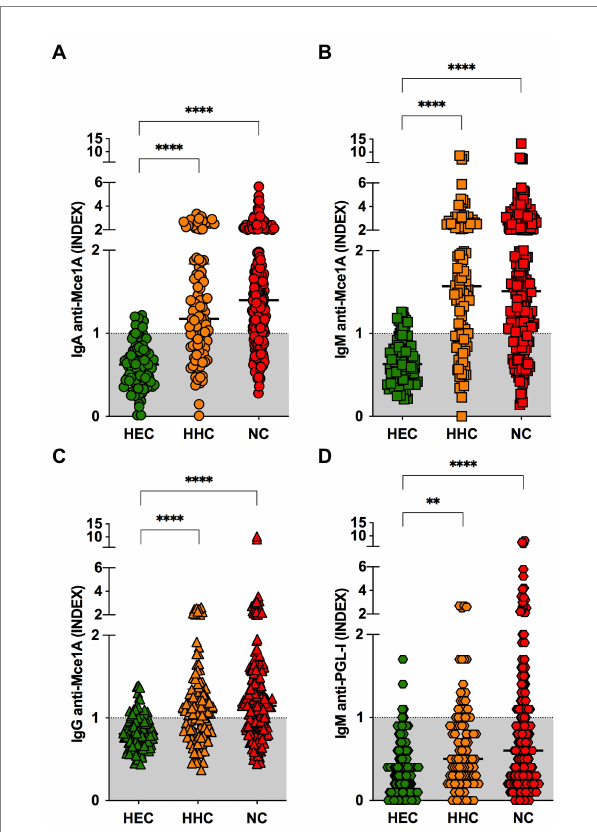
FIGURE 1 Biomarkers for the diagnosis of HD patients and their contacts. IgA (A) , IgM (B) , IgG (C) α -Mce1A, and anti-PGL-I (D) antibody indexes in plasma samples from HEC ( n = 100), HHC ( n = 105); and NC ( n = 200).